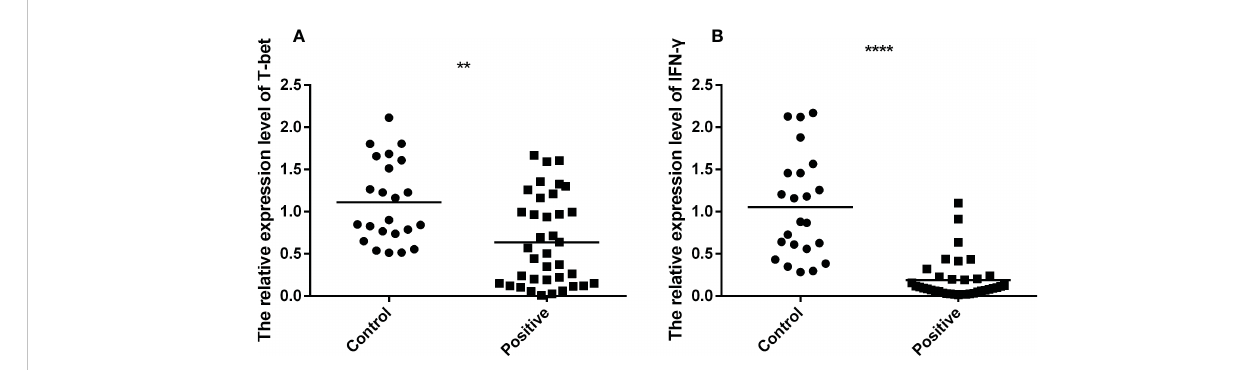
FIGURE 3 The mRNA expression of T-bet and IFN- g of active TB patients ( n =37) and healthy controls ( n =23) were tested by RT-QPCR. The data were normalized quotient to b -actin and presented as the mean ± SD of three independent tests, performed by Mann-Whitney U test (Wilcoxon rank sum